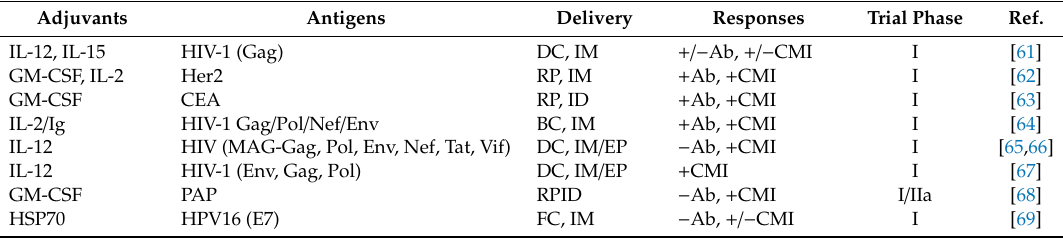
Table 2. Molecular adjuvants tested with DNA vaccines in